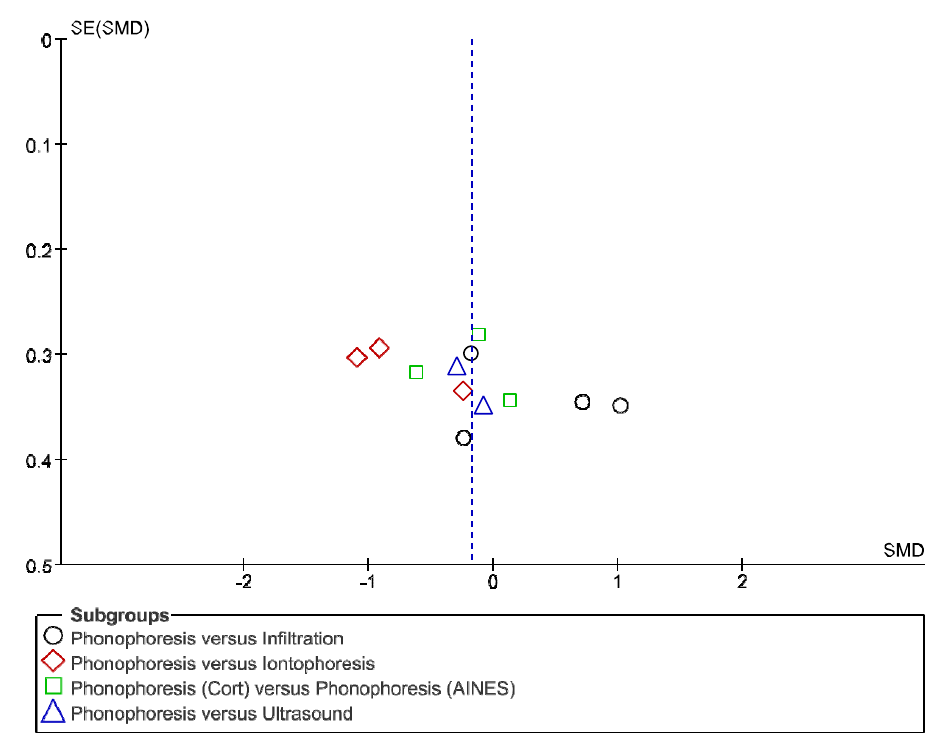
Figure 17. Phonophoresis for BCTQ Total.